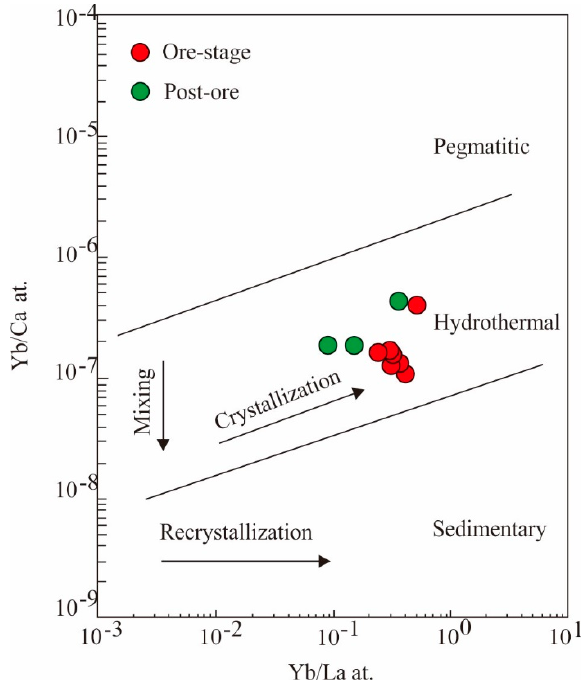
Figure 6. Yb/La vs. Yb/Ca plot for calcites from the Zhesang gold deposit [44].